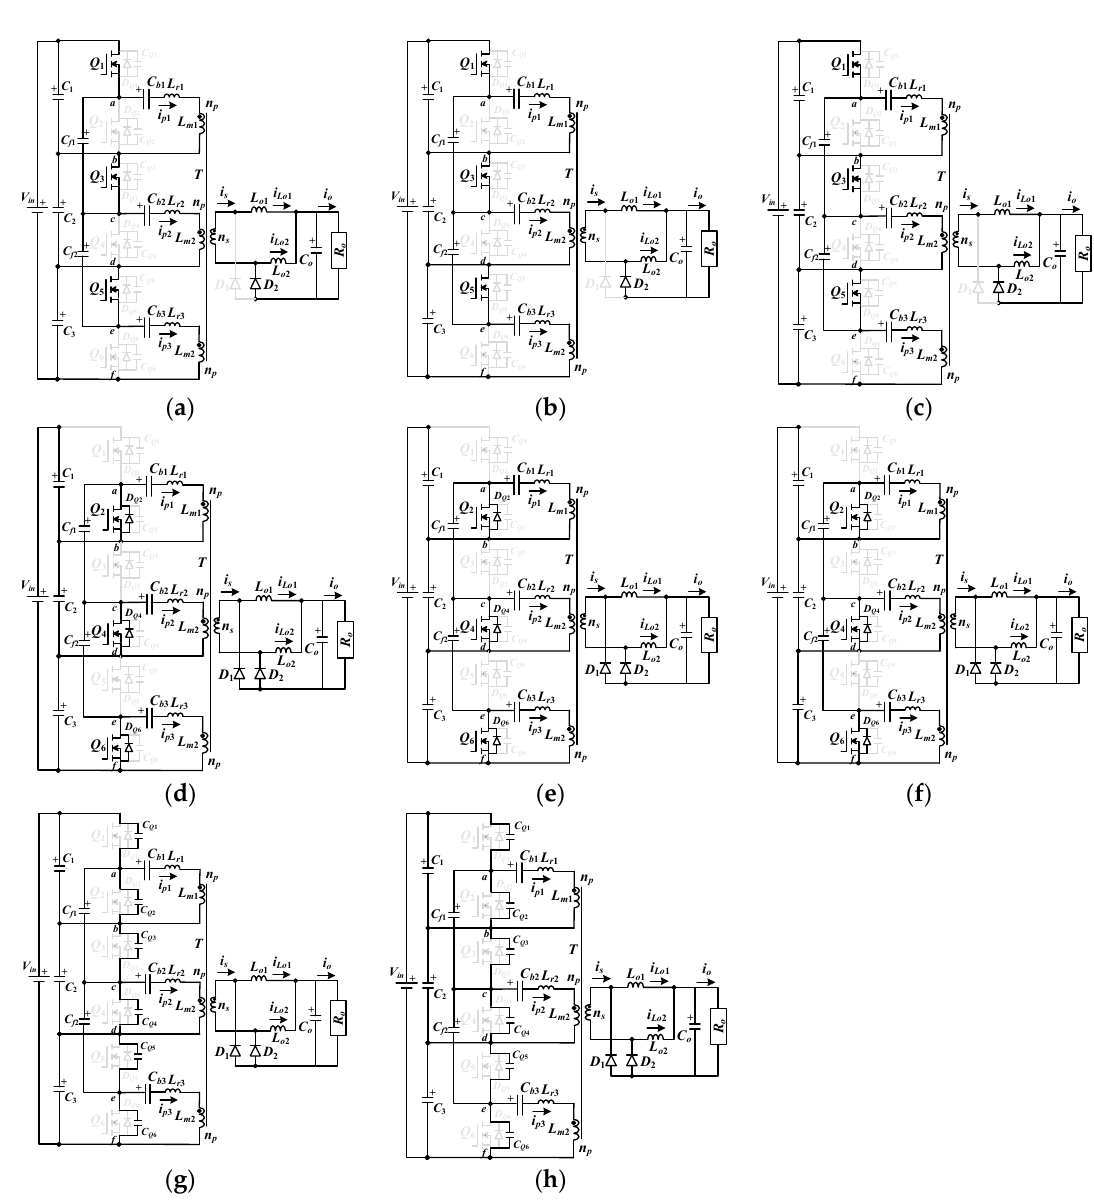
Figure 5. Operation steps of the power converter during one switching cycle ( a ) step 1 ( b ) step 2 ( c ) step 3 ( d ) step 4 ( e ) step 5 ( f ) step 6 ( g ) step 7 ( h ) step 8.